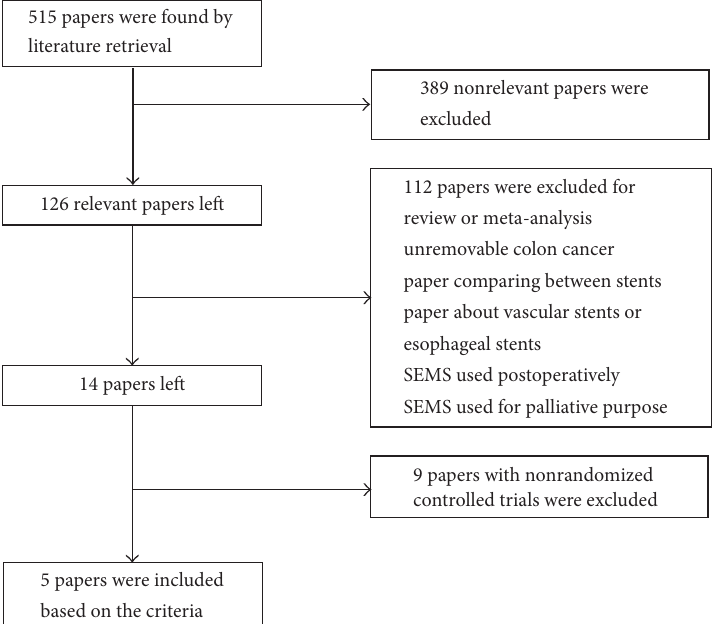
Figure 1: Flowchart for literature